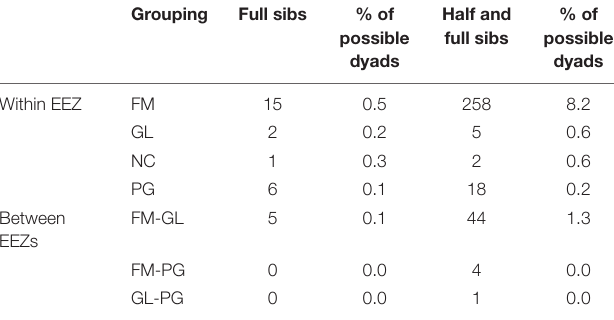
TABLE 4 | The distribution of kin dyads, organized by population sample, catch event,